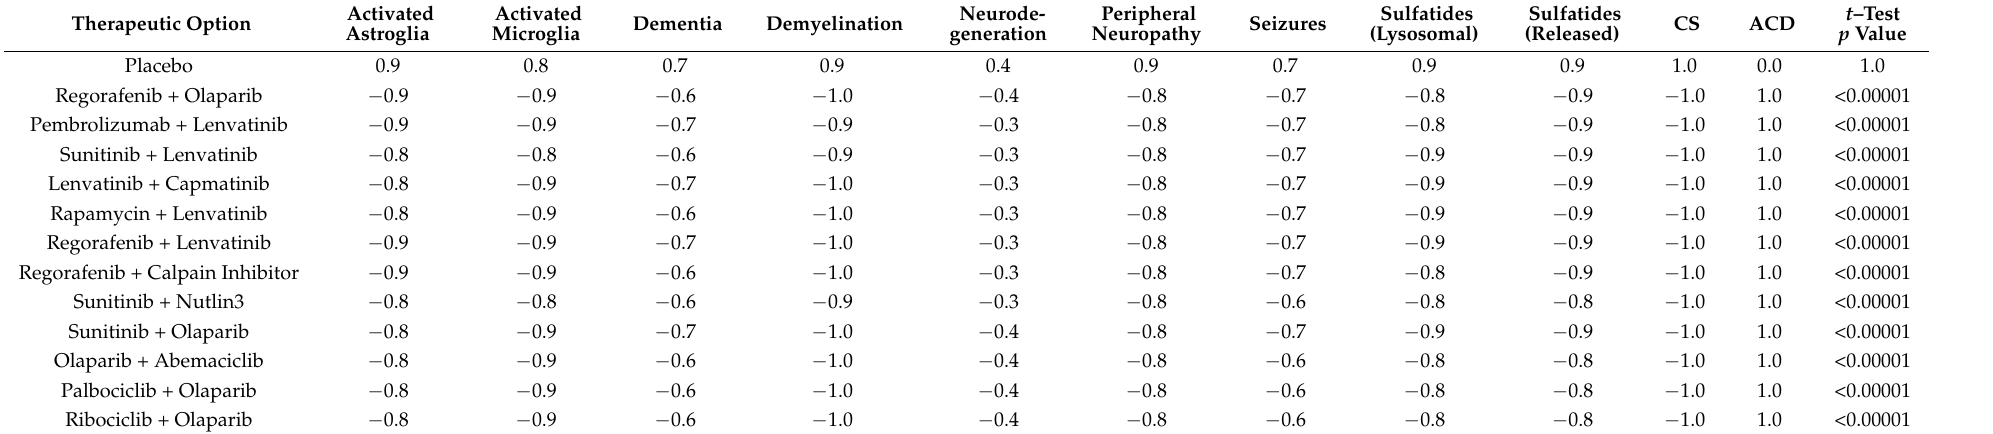
Table 3. Effect of top double drug combinations on